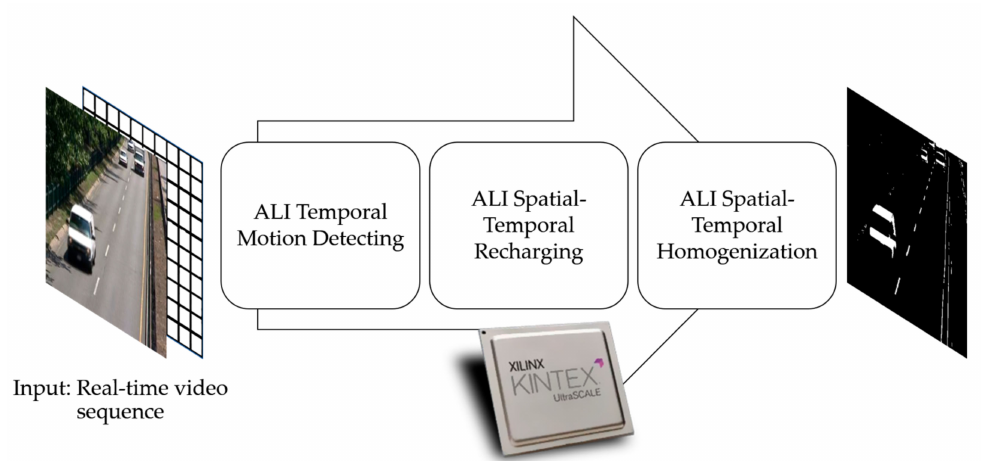
Figure 1. Deployment of the ALI method for use in motion